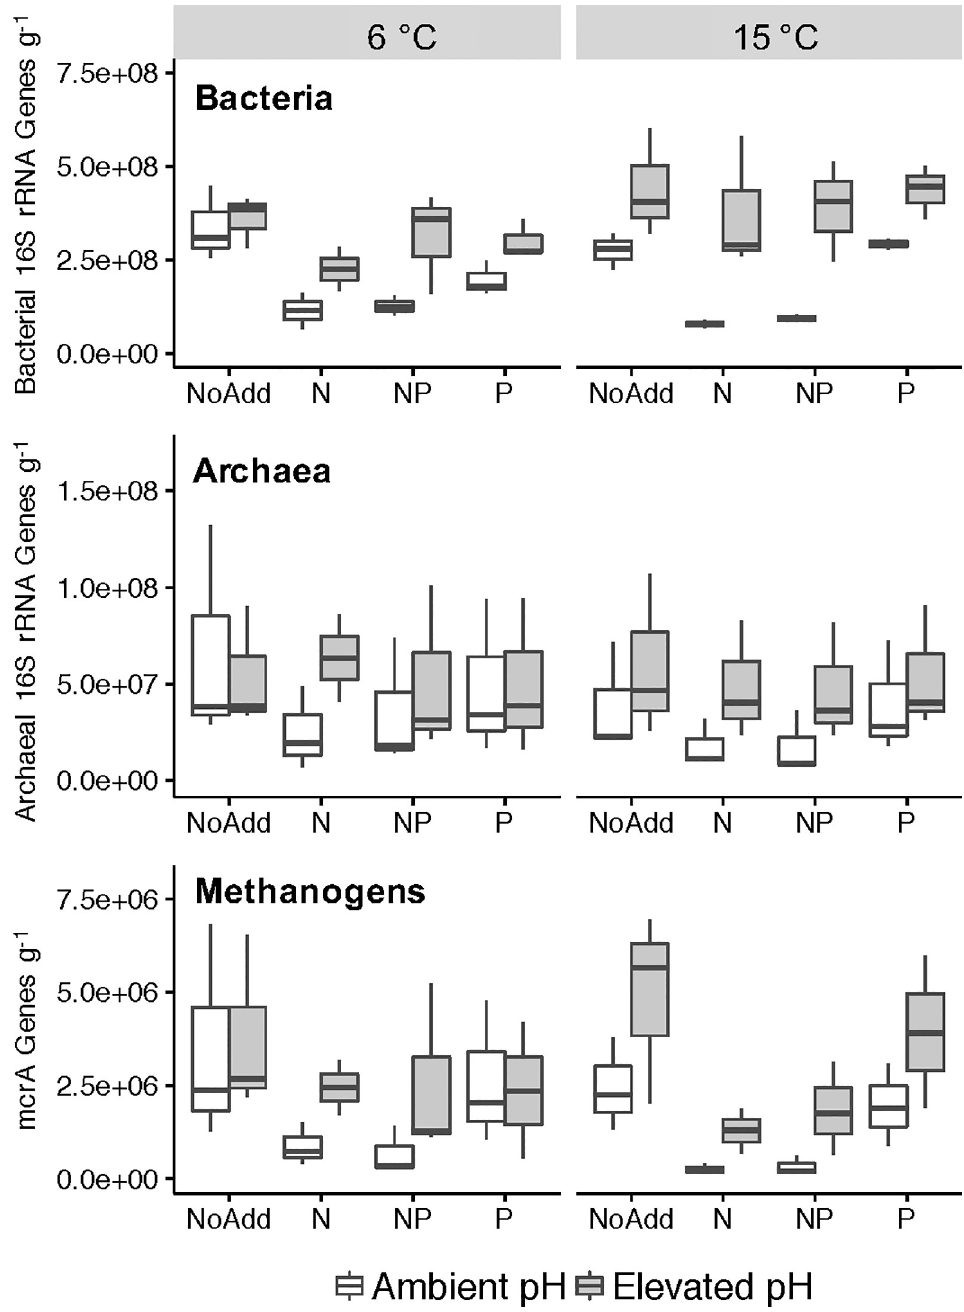
Fig 2. Bacterial, Archaeal, and methanogen abundance measured by qPCR after 70 days of microcosm incubations. Bacterial and archaeal population sizes were determined by quantifying 16S rRNA gene copies and methanogens were assessed by quantifying mcrA gene copies. pH adjustment treatments are shown in grey, and unadjusted treatments are shown in white. Abundance is presented as gene copies per g dry